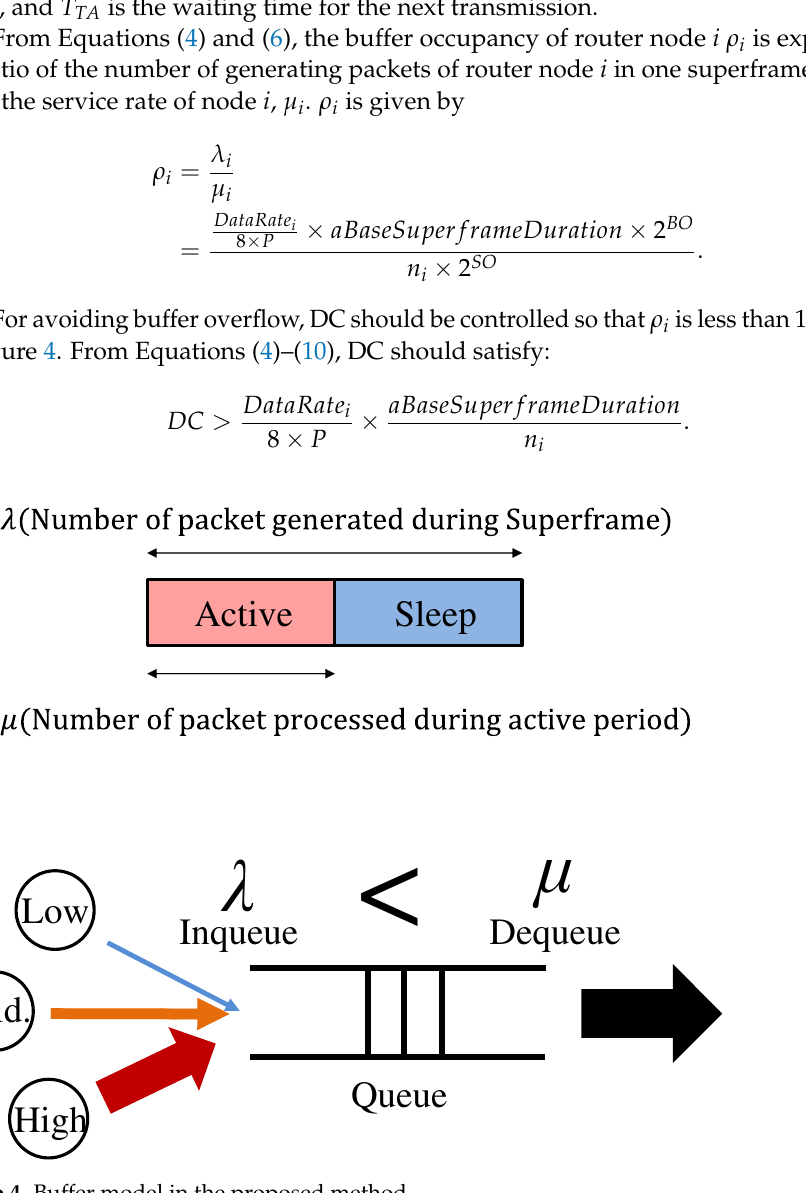
Figure 4. Buffer model in the proposed